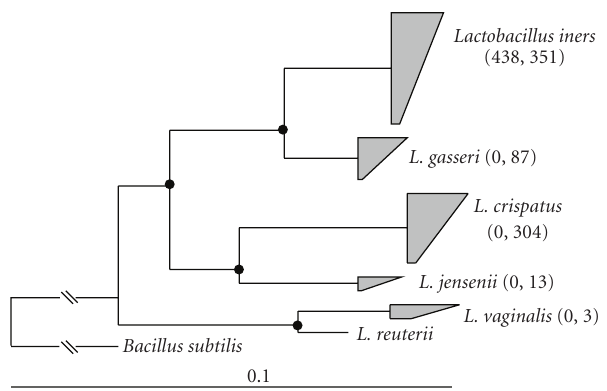
Figure 2: Neighbor joining based phylogeny of the 1,196 Lac- tobacillus 16S rRNA gene clones obtained in this study. Clones that were closely related to known Lactobacillus species were condensed into trapezia. Numbers in parentheses represent, for each group, the number of clones obtained from participants with bacterial vaginosis (left) and without bacterial vaginosis (right). The phylogeny is based on 503 unambiguously aligned nucleotides. Branch points with > 75% conservation are represented with a closed circle; branch points with 50–74% conservation are shown with an open circle. Genbank accession numbers for reference species are shown in brackets. A 16S rRNA gene from Bacillus subtilis was used as the outgroup. Scale bar represents 0.1 change per